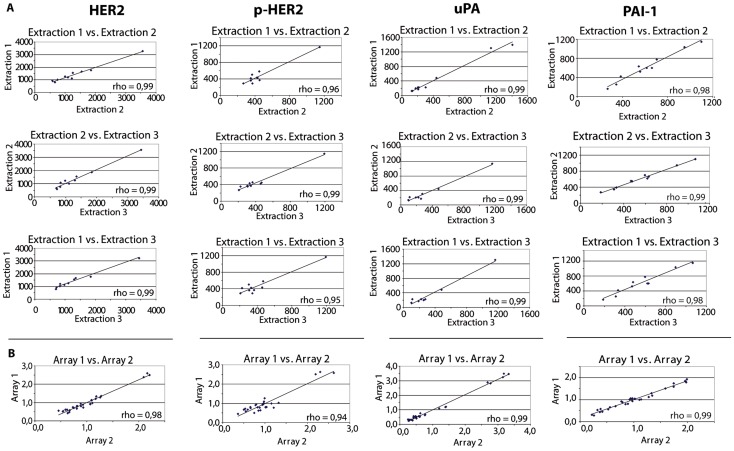
Reproducibility of protein extraction and reverse-phase-protein-arrays.Bivariate correlations of HER2, pHER2, uPA and PAI-1 expression (A) from three independent protein extractions and (B) from two independent RPPA analyses. Graphs are showing the Spearman’s rho for each pairwise correlation.